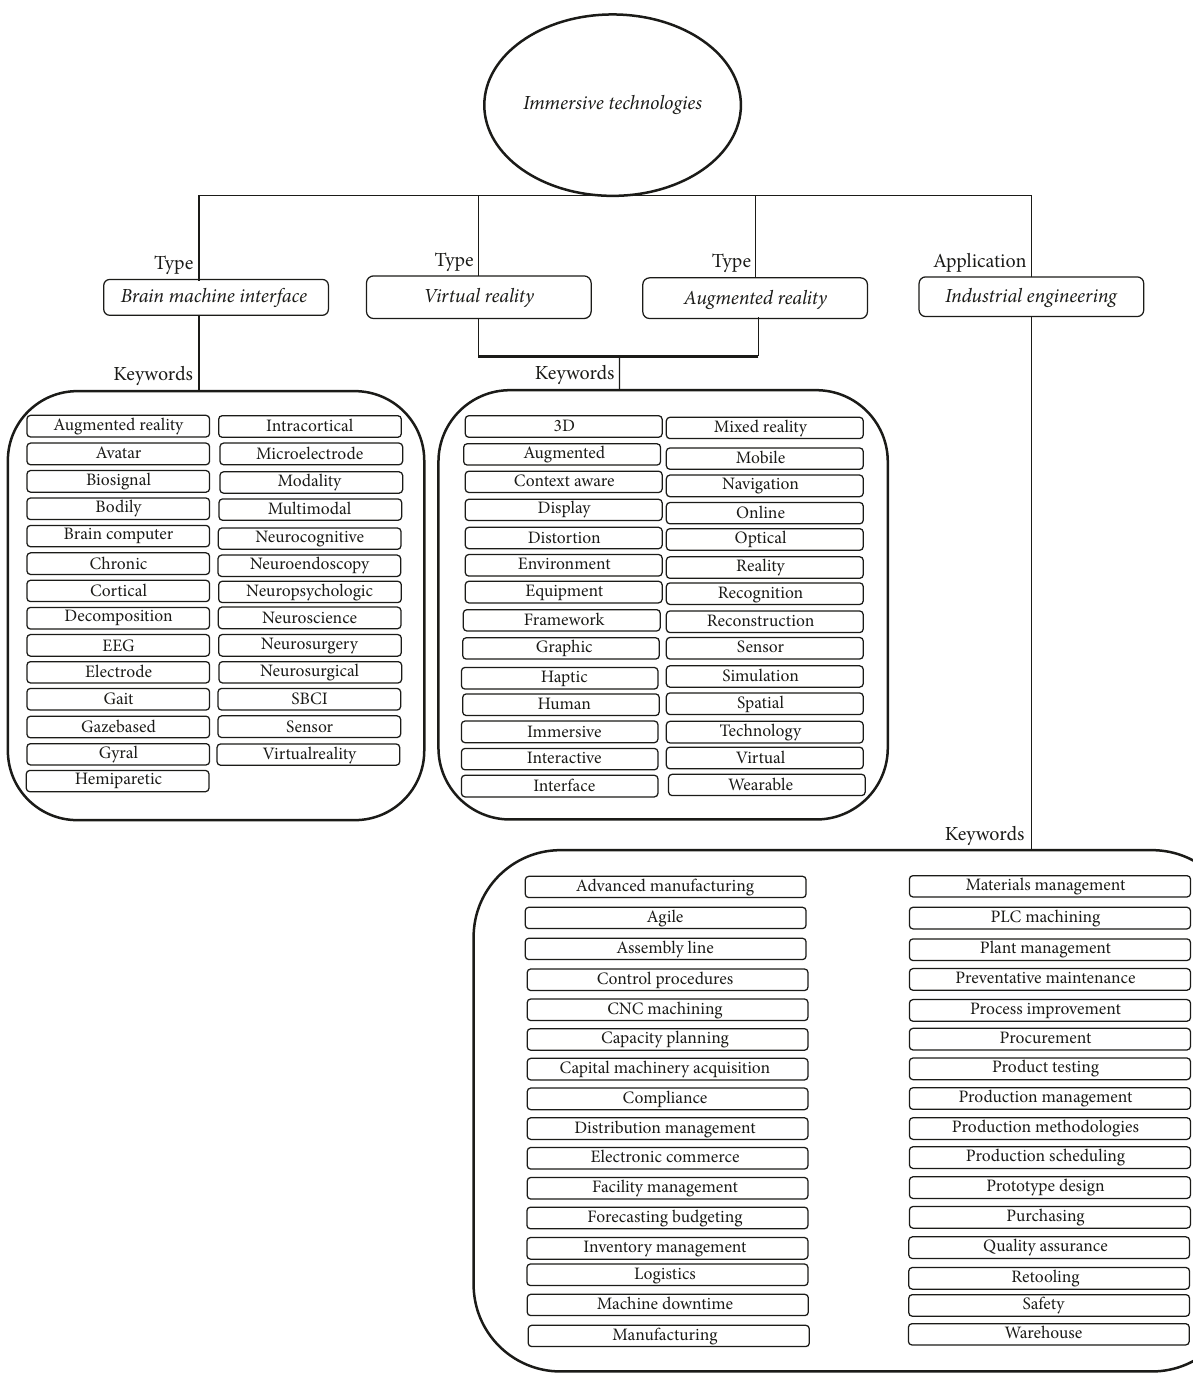
Figure 3: Ontology schema of